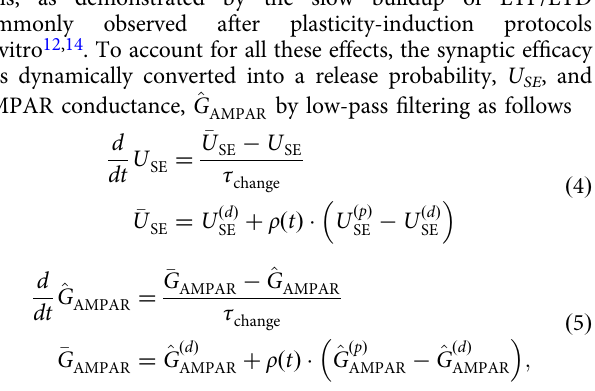
stimulation (Fig. 2a middle).